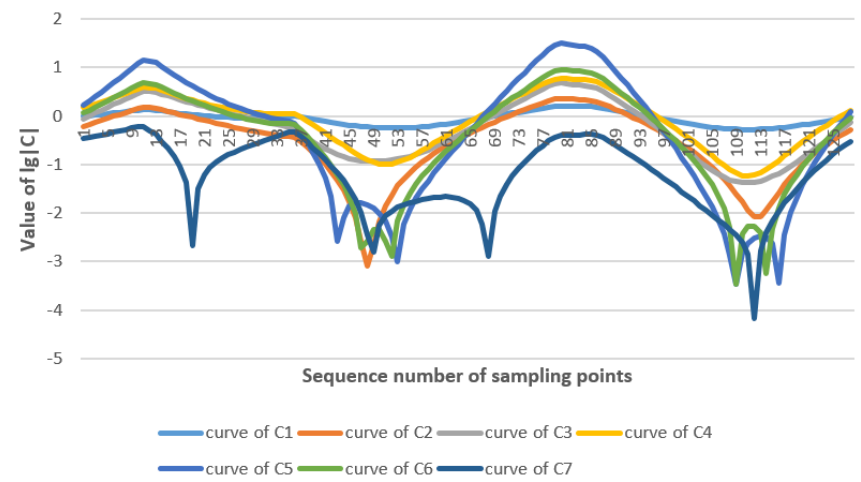
Figure 6. The lake at different scales: ( a ) the lake in scale of 1:10,000 and ( b ) the lake in scale of 1:50,000.